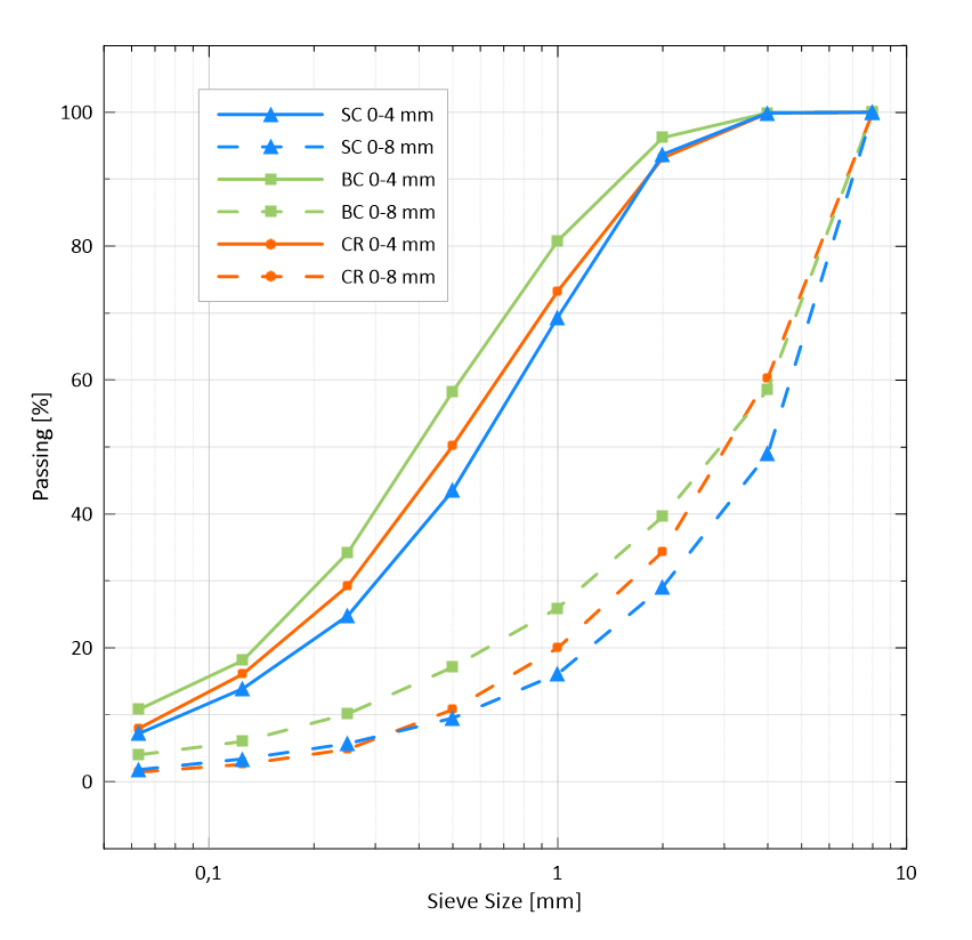
Figure 2. The grain-size distribution curves of the aggregates